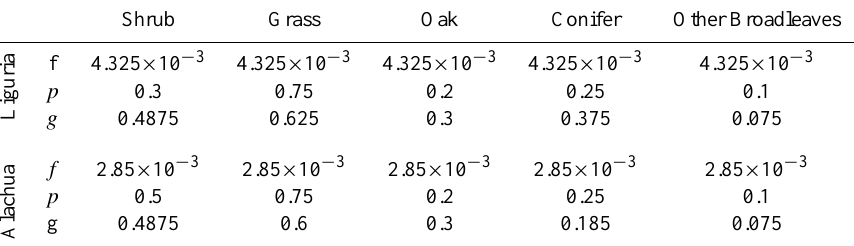
Table 1. Parameters of the Modified Forest Fire Model; f is the probability of ignition, g is the probability of spread, p is the probability of